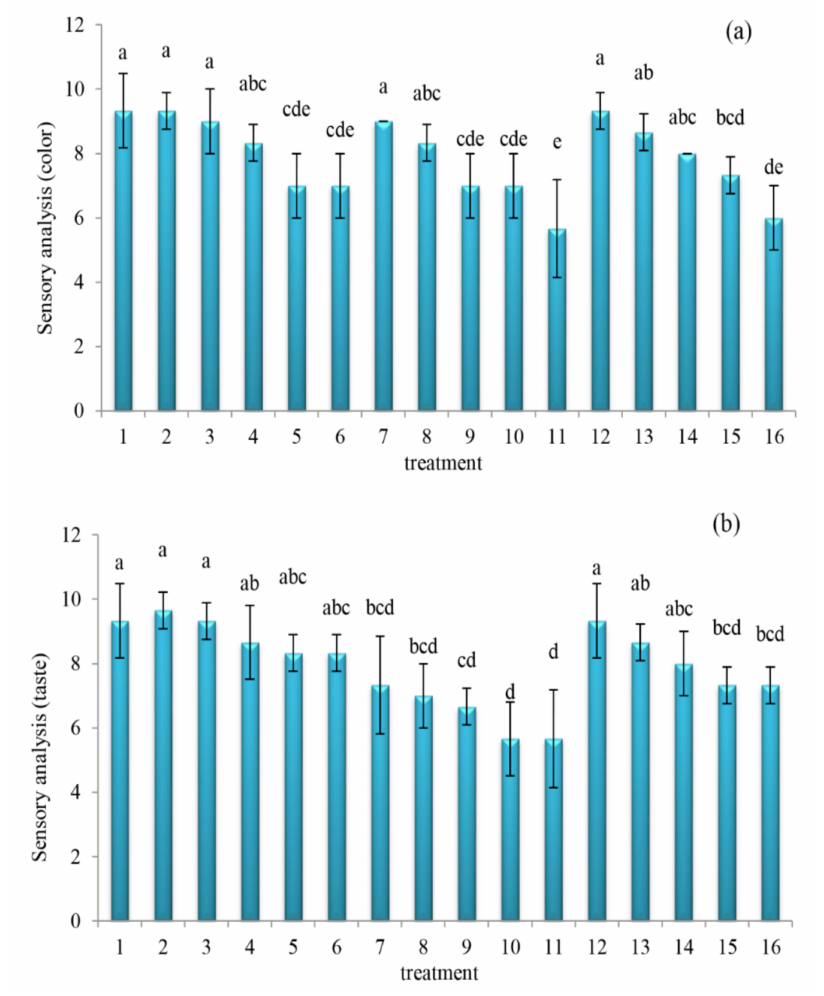
Figure 4. Changes in sensory color ( a ) and taste ( b ) values of orange juice subject to different oleaster extracts ((1) control, (2) aqueous extract 5%, (3) aqueous extract 10%, (4) aqueous extract 15%, (5) aqueous extract 20%, (6) aqueous extract 25%, (7) alcoholic extract 5%, (8) alcoholic extract 10%, (9) alcoholic extract 15%, (10) alcoholic extract 20%, (11) alcoholic extract 25%, (12) hydro-alcoholic extract 5%, (13) hydro-alcoholic extract 10%, (14) hydro-alcoholic extract 15%, (15) hydro-alcoholic extract 20%, (16) hydro-alcoholic extract 25%). Different letters (a–e) indicate significant changes occurred at p <